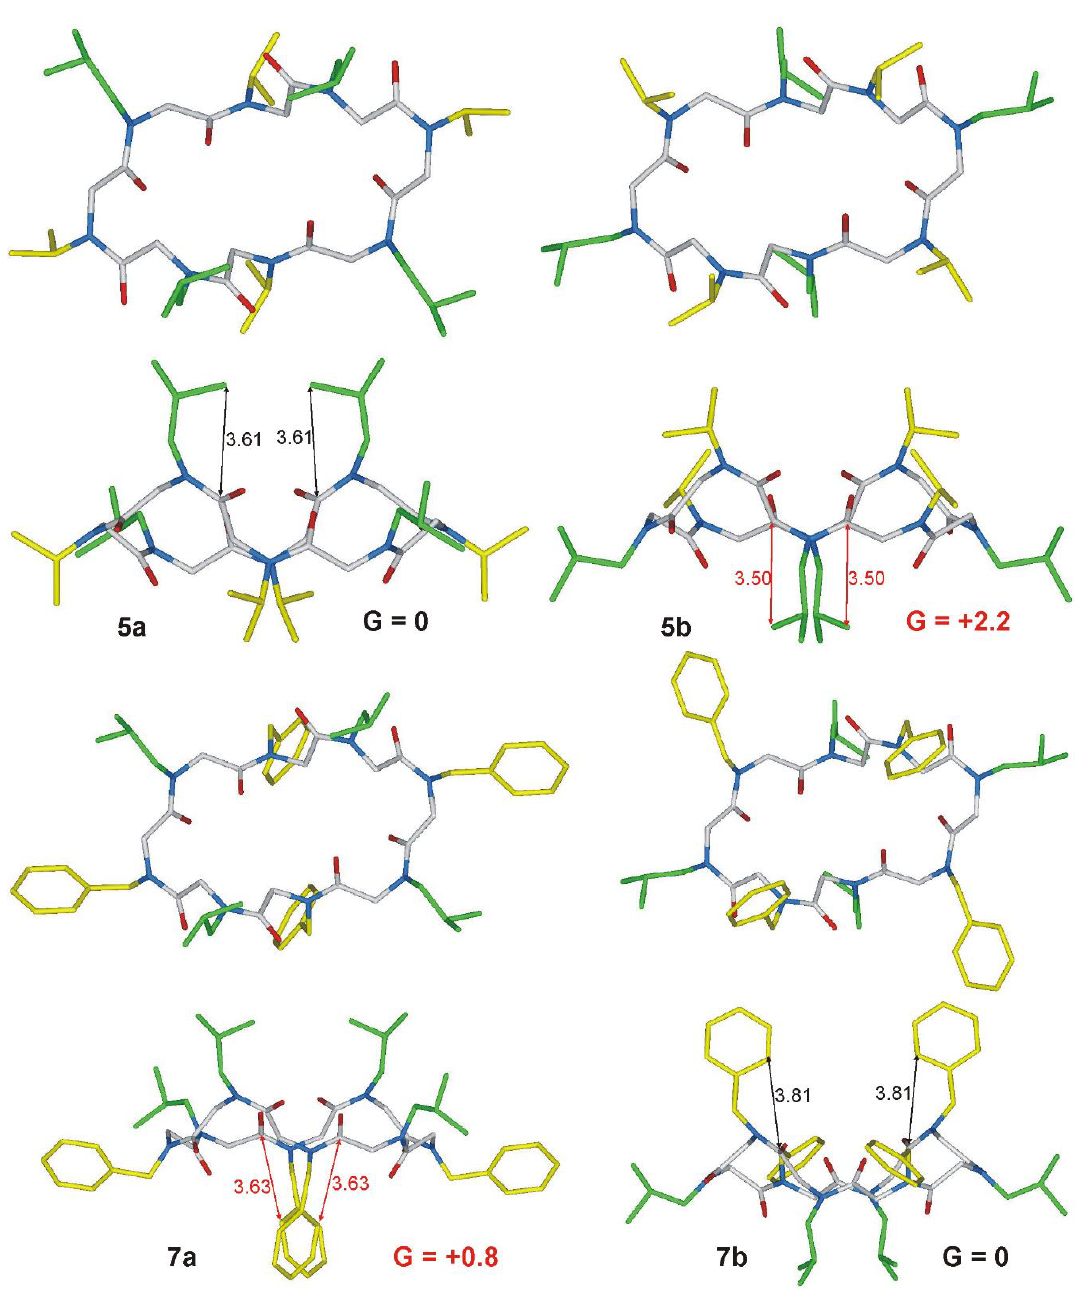
Figure 4. Top and side view of minimum energy structures of conformational diastereisomers 5a/b and 7a/b . For the sake of clarity isobutyl groups are reported in green, whereas isopropyl and benzyl groups in yellow. Free energies were calculated in CHCl 3 and reported in kcal/mol. Distances are reported in Å .